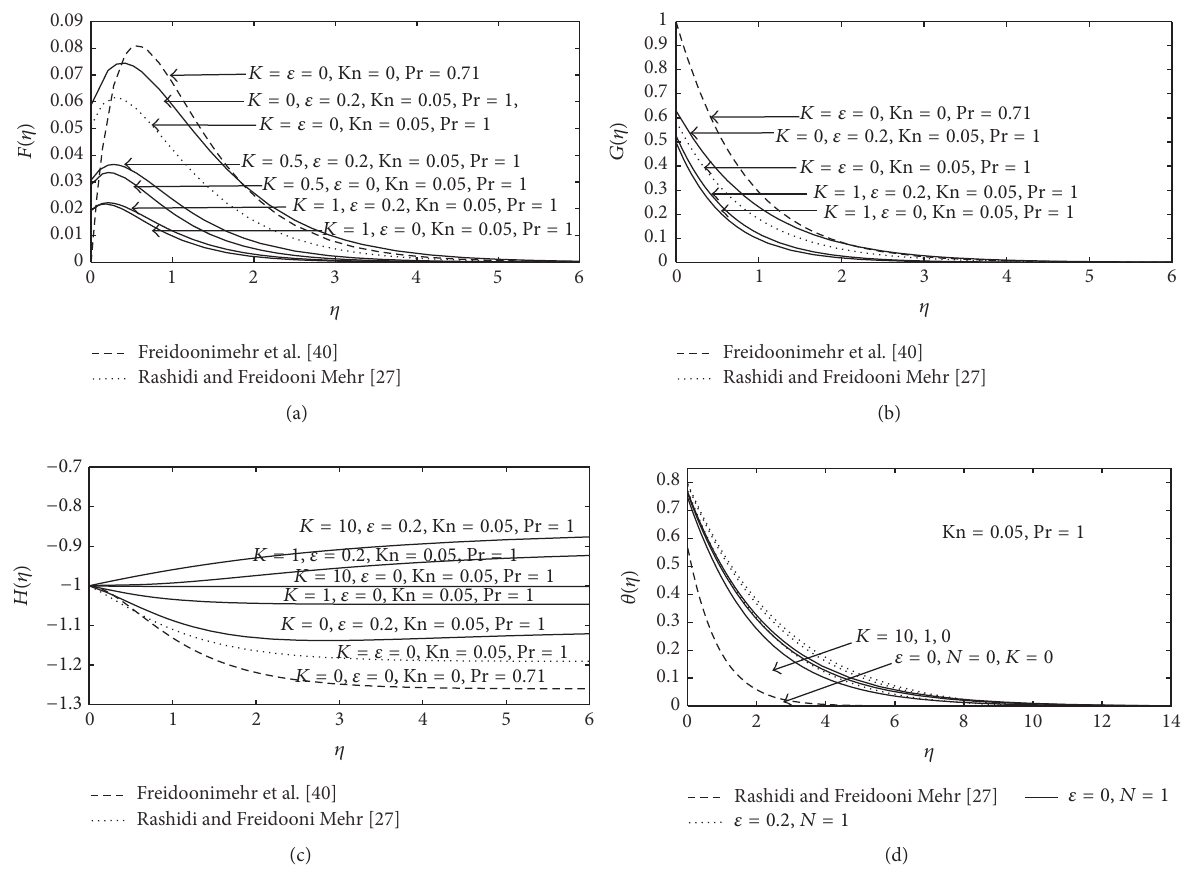
Figure 2: Effect of variation in the porosity parameter on the (a) radial, (b) tangential, (c) axial, and (d) temperature velocity profiles when = −1 and Re = 𝑊 𝑠